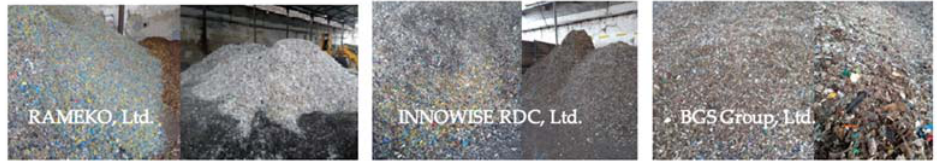
Figure 2. Solid recovered fuel deliveries. Source: Own processing by Vojany black coal power plant (2020).